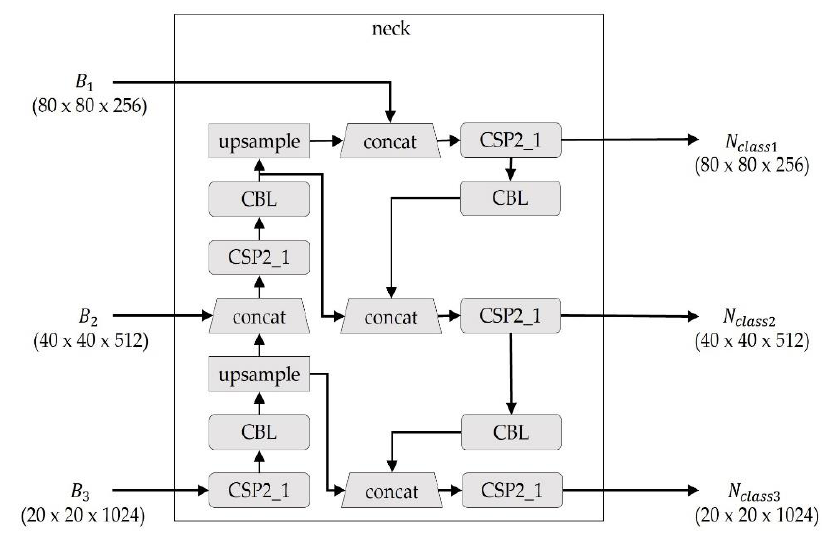
Figure 4. Neck module for efflorescence and spalling.